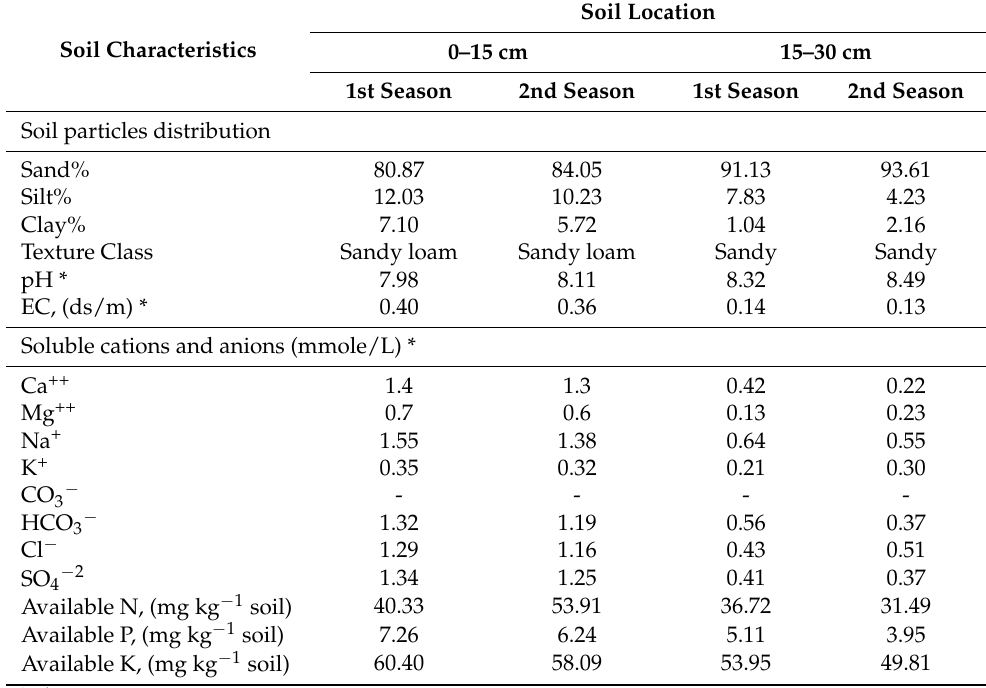
Table 1. Some physical and chemical properties of the selected soil in the two seasons of investigation.